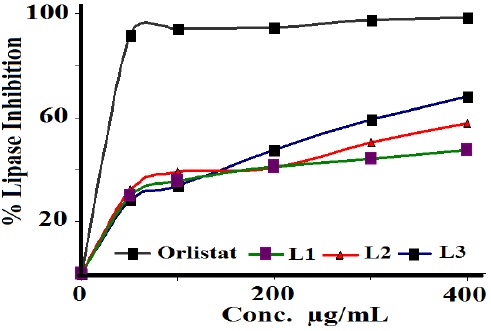
Figure 10. Pancreatic porcine lipase inhibition assay of L1 – L3 with Orlistat as the reference.